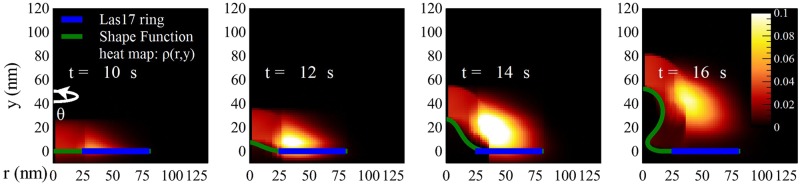
Time evolution of the F-actin distribution and the membrane profile.The F-actin density ρ(r, y) (red) at four time points during the time course of endocytosis in wild-type cells is shown by the heat map. The cell membrane is in green and the Las17 is in blue.